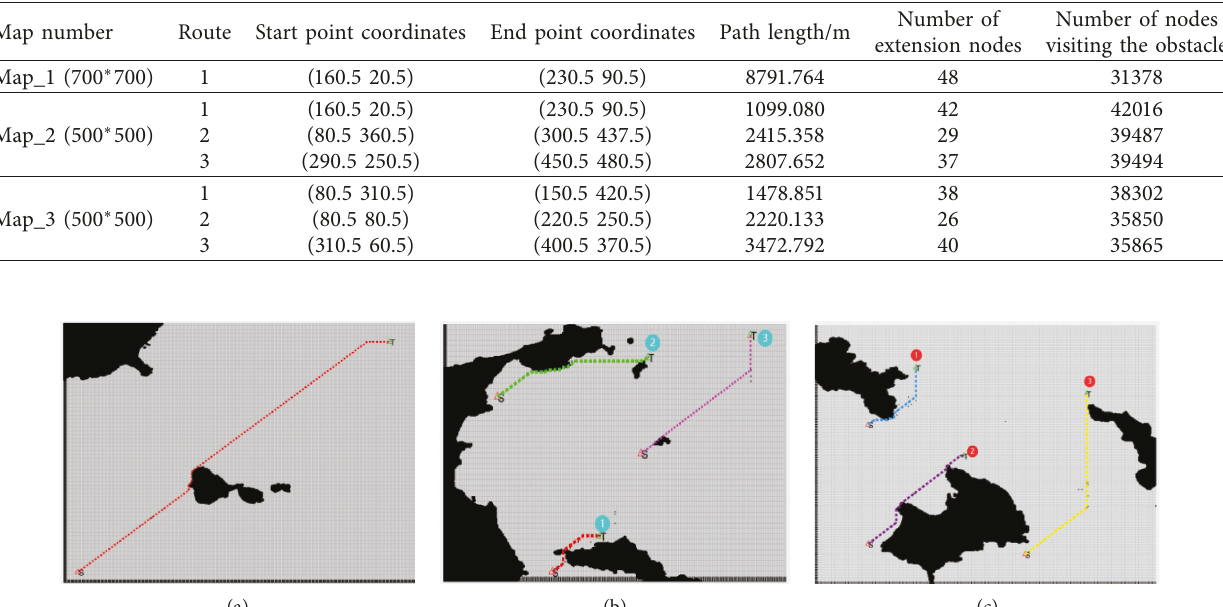
Table 3: Our algorithm for large-scale map path planning.